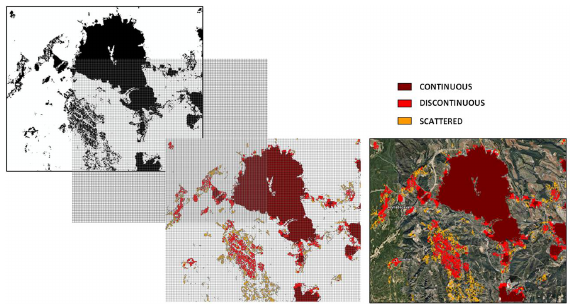
Figure 7. Result of cluster analysis about urban texture